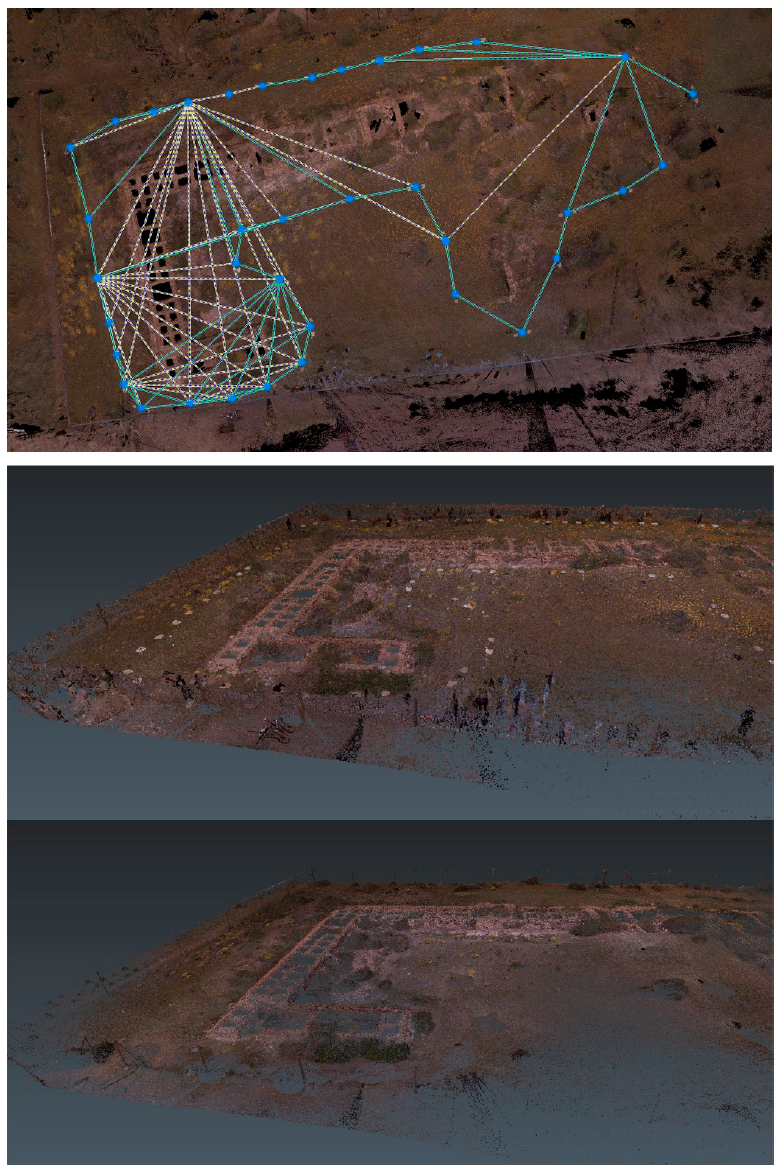
Figure 8. Photogrammetric process and treatments. Top image: position of the scan control points (in blue); central and bottom images: details of the obtained point cloud.